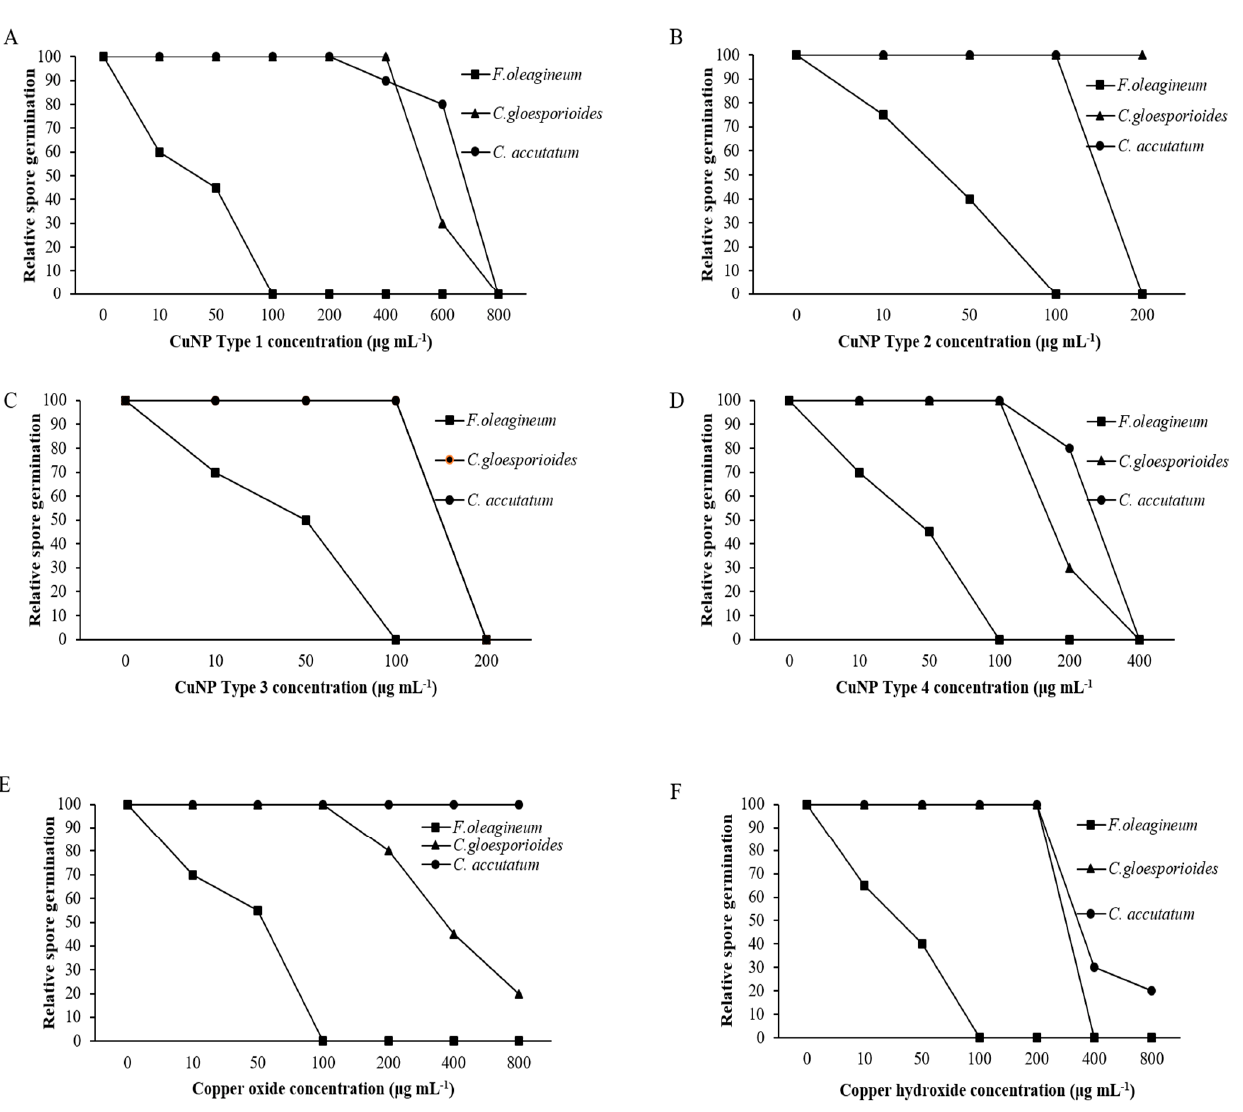
Figure 6. Mean relative spore germination of Fusicladium oleagineum , Colletotrichum acutatum s.s., and Colletotrichum gloesporioides s.s. isolates on artificial nutrient media amended with several concentrations of CuNP Type 1 ( A ), CuNP Type 2 ( B ), CuNP Type 3 ( C ), CuNP Type 4 ( D ), Copper oxide ( E ), and Copper hydroxide ( F ).